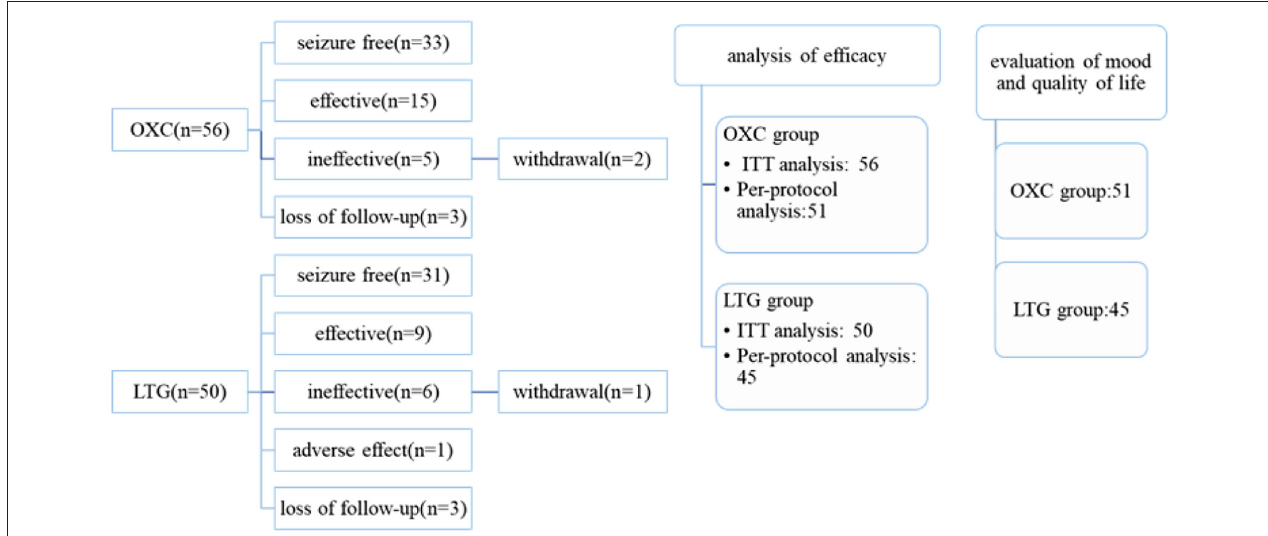
FIGURE 1 | Schematic diagram for patients receiving LTG and OXC monotherapy.